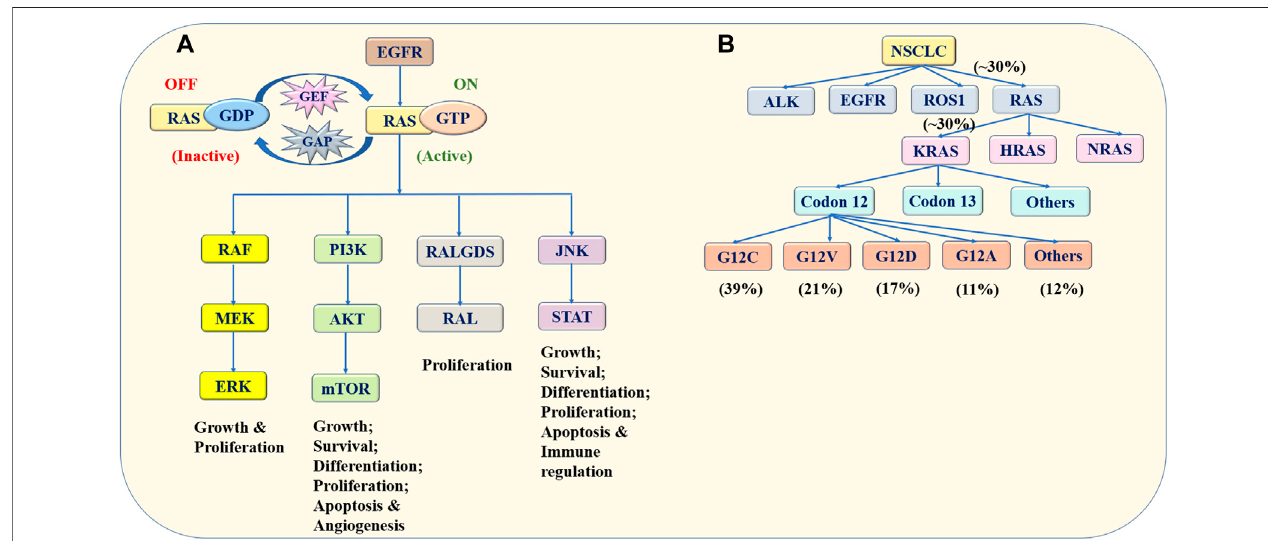
FIGURE 1 | Schematic presentation of the RAS family. (A) Switching mechanism and signaling pathways of the RAS protein. The RAS protein switches between the GDP-binding inactive state and GTP-binding active state in fl uenced by GAP and GEF. Once stimulated by external signals, such as the EGFR mutation, RAS/GDP changes into RAS/GTP, leading to the hyperactivation of downstream signaling cascades. The downstream pathways of the RAS protein include the RAF/MEK/ERK, PI3K/AKT/mTOR,RALGDS/RALandJNK/STATpathways,whichareassociatedwithtumorcellproliferation,differentiation,apoptosisandsurvival. (B) Frequency and classi fi cation of RAS mutation in NSCLC. KRAS, HRAS and NRAS are members of the RAS family, which is associated with NSCLC. Among them, the KRAS mutation isthemost common mutation. TheKRAS mutation exists mainly at codon 12. TheG12C, G12V, G12D, and G12Amutations accountfor 39, 21,17, and 11% of all KRAS mutations, respectively. Data acquired from Memorial Sloan-Kettering Cancer Center. Abbreviation: RAS, rat sarcoma viral oncogene homolog; GDP, guanosine diphosphate; GTP, guanosine triphosphate; EGFR, epidermal growth factor receptor; RAF, rapidly accelerated fi brosarcoma; MEK, extracellular regulated protein kinase; ERK, extracellular regulated protein kinase; PI3K, phosphatidylinositol 3 kinase; mTOR, mammalian target of rapamycin; RALGDS, Ral Guanine Nucleotide Dissociation Stimulator; RAL, Ras-related GTPase; JNK, c-Jun N-terminal kinase; STAT, signal transducer and activator of transcription; NSCLC, non-small cell lung cancer; KRAS, Kirsten rat sarcoma viral oncogene homolog; HRAS, Harvey rat sarcoma viral oncogene; NRAS, Neuroblastoma rat sarcoma viral oncogene.